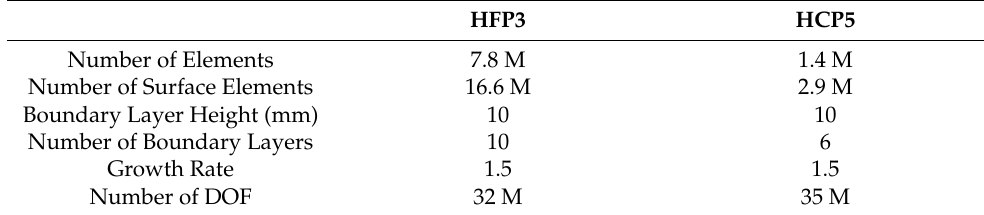
Table 1. Summary of the main characteristics of